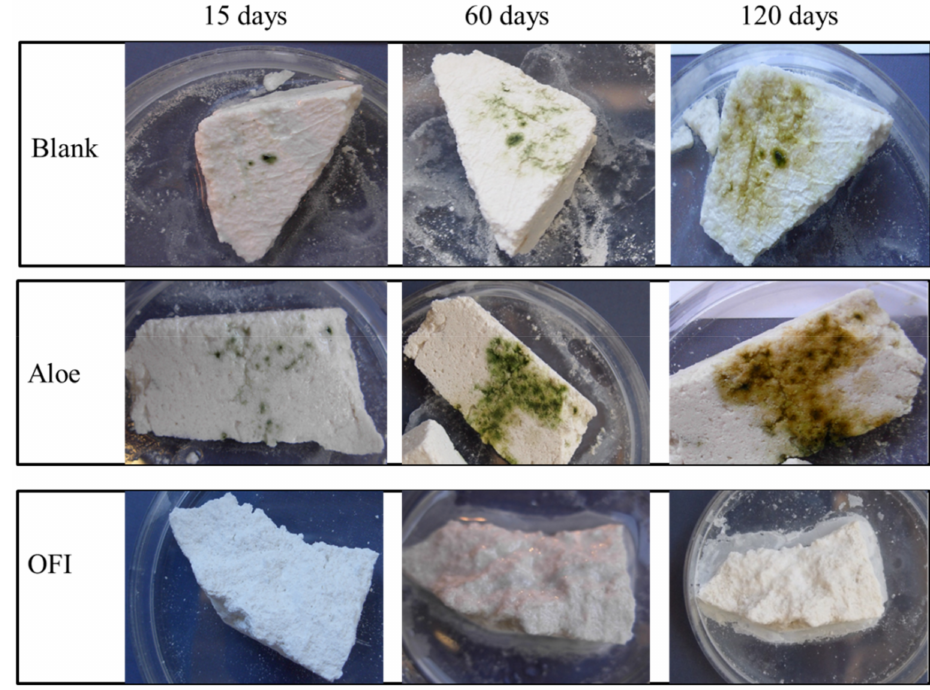
Figure 6. Mortar (blank) and bio-mortar samples (added with Aloe and OFI) 15 days, 60 days and 120 days after inoculation with a photosynthetic